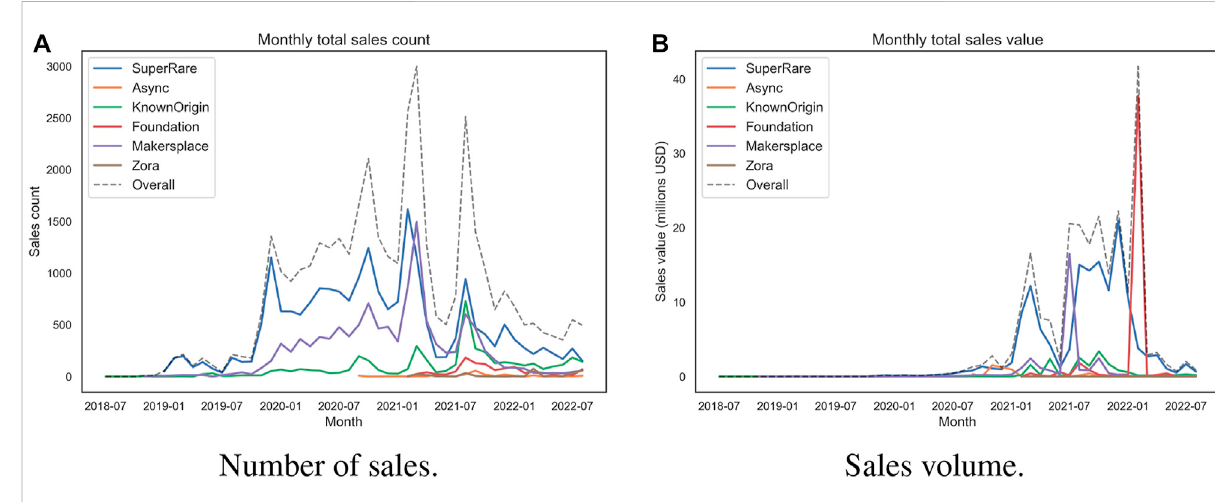
NFT art market overview. (A) Number of sales. (B) Sales